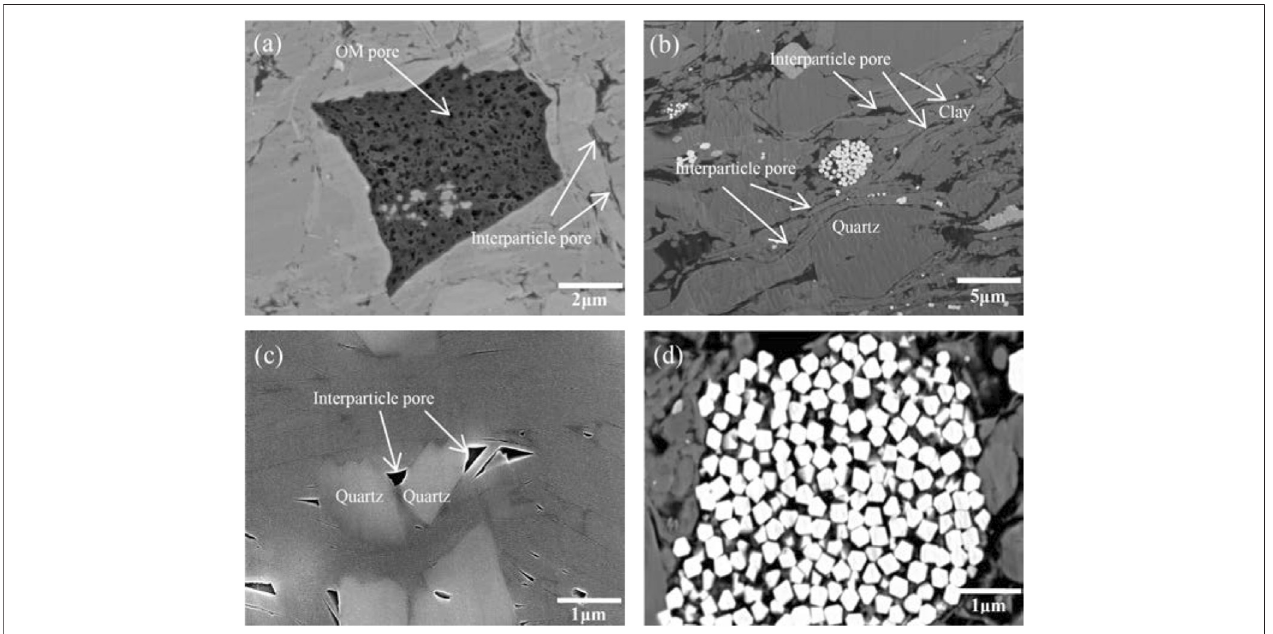
FIGURE 4 | Examples of pore type observed on BES. (A) organic-matter pores (OM pore) and interparticle pores (Sample C37; TOC: 5.1%; Porosity: 3.2%; 2452 m). (B) interparticle pores with the shape of elongated ellipsoid between aligned clay (Sample C15; TOC: 2.74%; Porosity: 2.8%; 2162 m). (C) interparticle pores with triangular shape between rigid quartz grains (Sample C31; TOC: 3.5%; Porosity: 2.2%; 2375 m). (D) intracrystalline pores within pyrite framboids (Sample C21; TOC: 2.7%; Porosity: 3.1%; 2288 m).